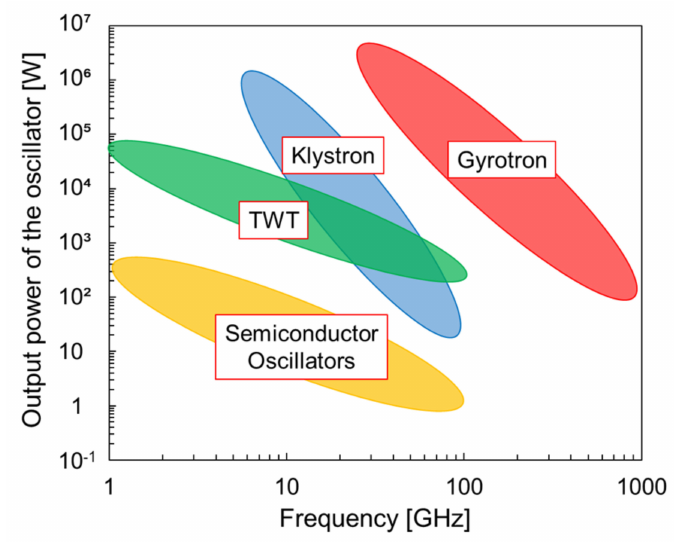
Figure 4. Schematic diagram showing the oscillation source output range for frequencies [19].